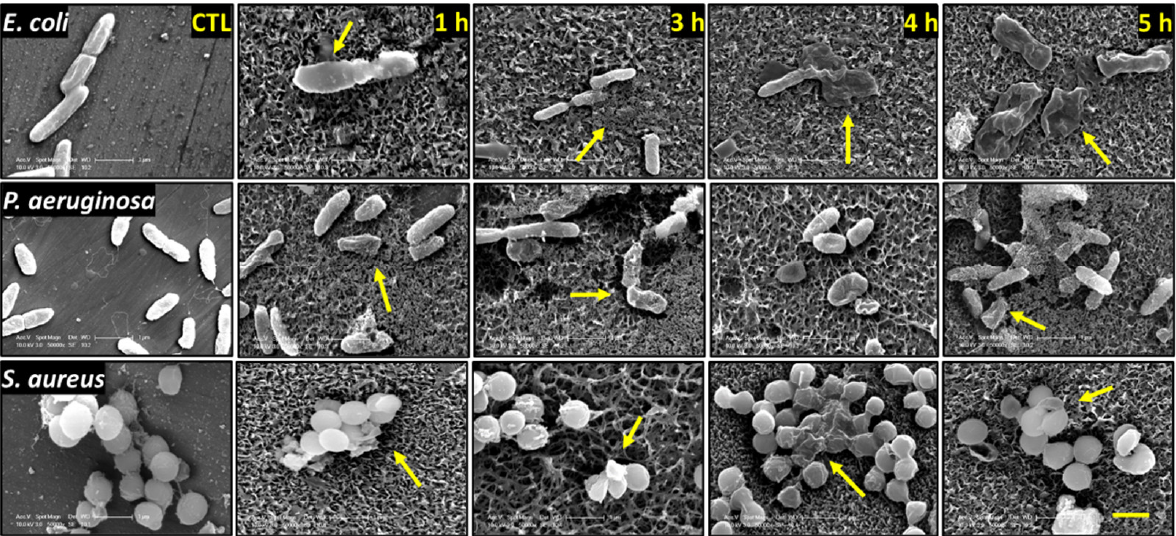
Figure 3. SEM micrographs of E. coli , P. aeruginosa , and S. aureus following 20 h incubation on the NaOH-etched samples (1, 3, 4, and 5 h etching time). Yellow arrows indicate damaged bacteria. SEM micrographs were acquired at 50,000 magnification, and scale bar bottom right image represents 1 µm.